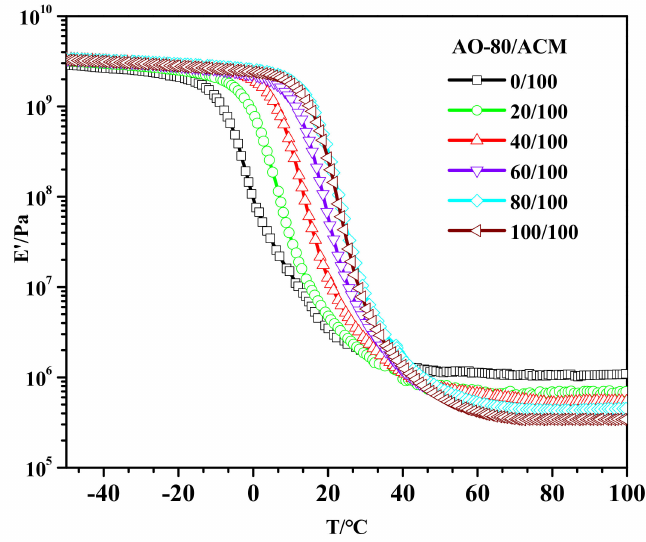
Figure 11. E (cid:48) –T curves of AO-80/ACM rubber